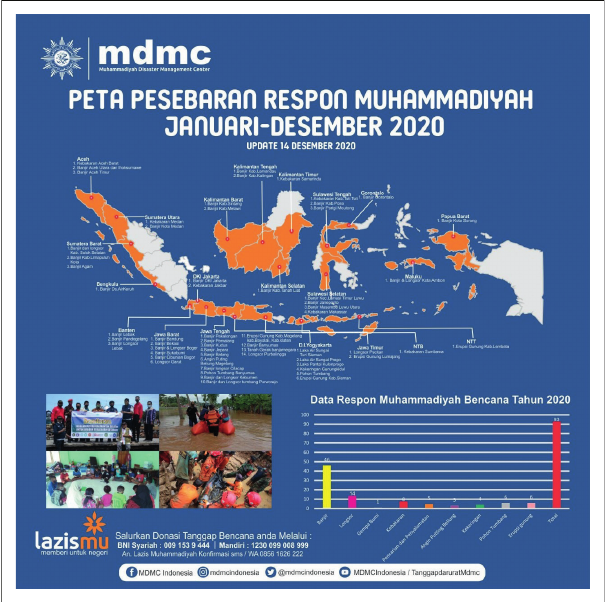
FIGURE 2: Muhammadiyah response beneficiaries from January to December 2020. FIGURE 1: Muhammadiyah response distribution map from January to December